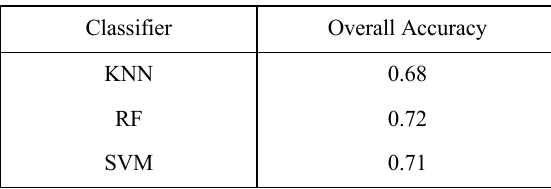
Table 1. 10-folder cross validation results by different